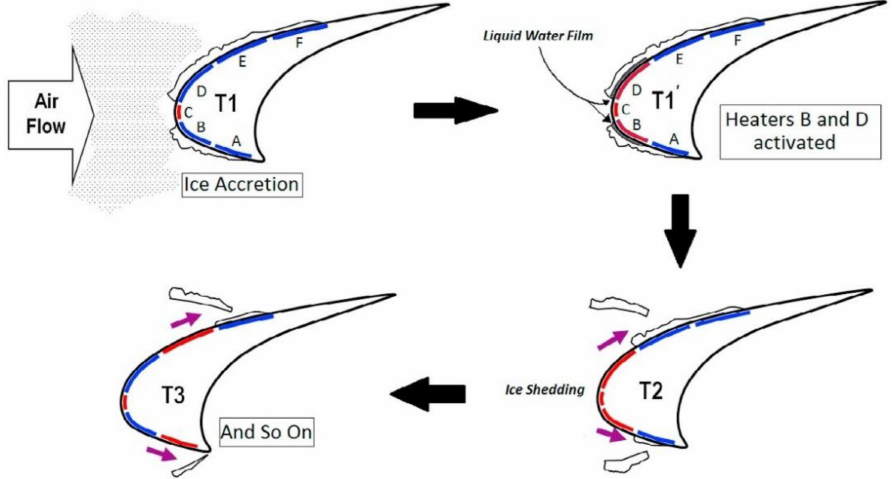
Figure 2. Illustration of the operation of an electro-thermal ice protection system (ETIPS) (reproduced from Huang et al. [39] with permission of